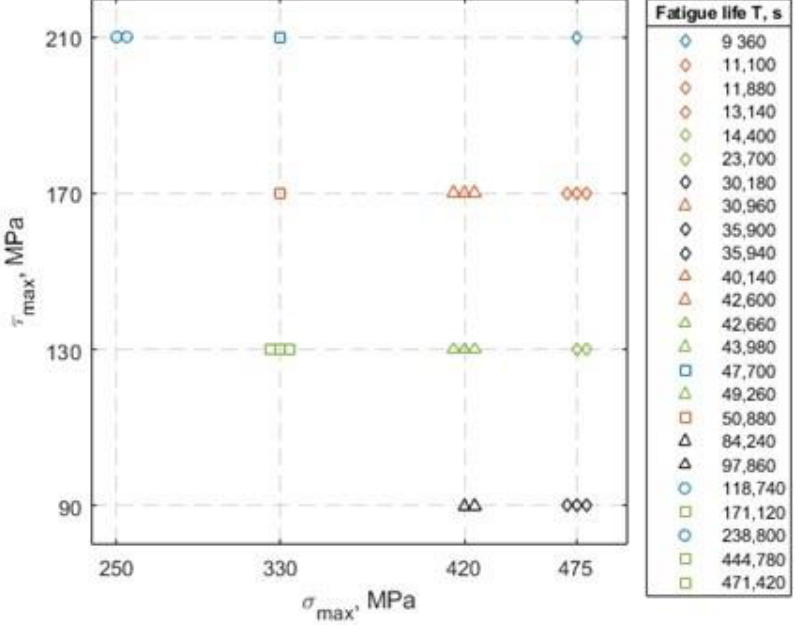
Figure 3. Maximum normal stress σ max and maximum shear stress τ max , grouped by fatigue life T .